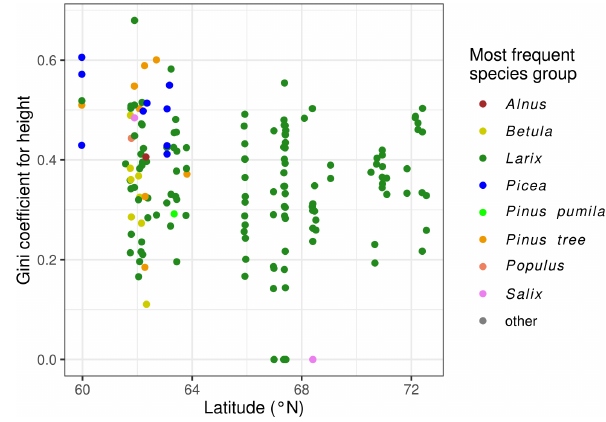
Figure 6. Gini coefficients for height against latitude, coloured by most frequent species on plot. (Plots with more diverse height dis- tributions have higher Gini